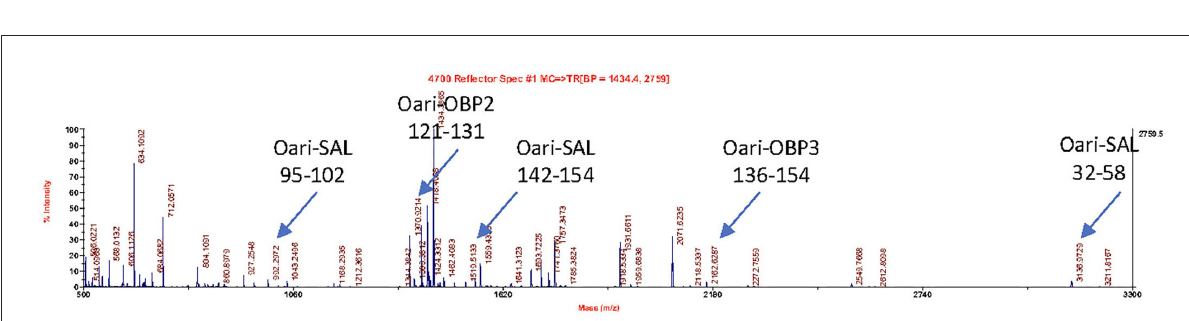
FIGURE3 MALDI-TOF spectrum of peptides resulting from the trypsin action on the 20 kDa band of the olfactory secretome of CTRL2 ewe (sampling time + 7 d). Arrows indicate m/z corresponding to Oari-OBP2, Oari-OBP3, and Oari-SAL peptides (listed in Supplementary Table 12). The position in the sequence is indicated